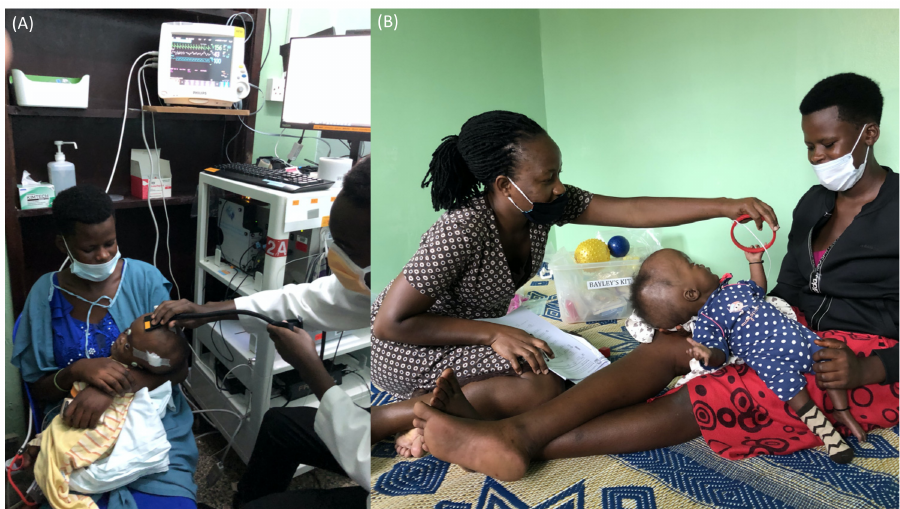
Figure 2. Example of ( A ) an FDNIRS-DCS study measurement and ( B ) a baseline neurodevelopmental outcome assessment with a